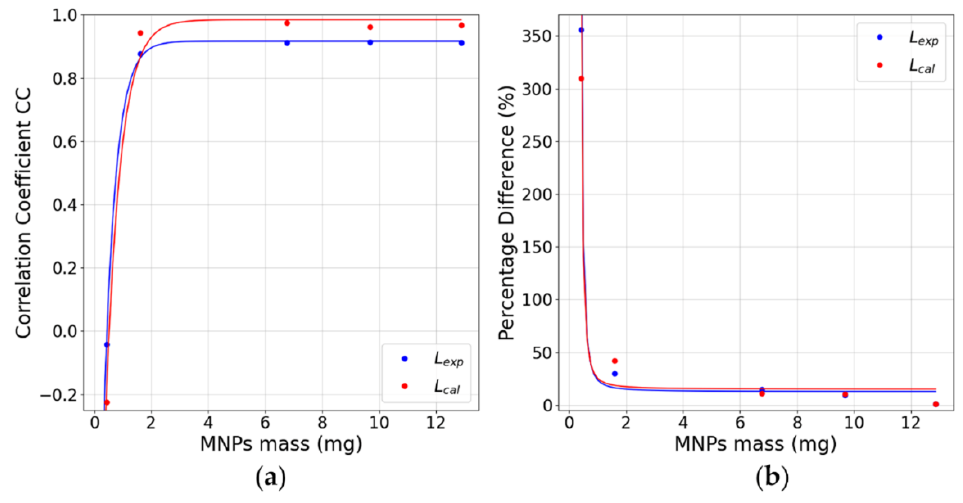
Figure 5. ( a ) CC values for reconstructing one cube in the FOV ’ s center. ( b ) 𝑋 𝑑𝑖𝑓𝑓 values for the reconstruction of one cube positioned in the FOV ’ s center. All graphs present the values for all MNP masses used. Fitted curves presented 𝑅 2 > 0.98. Table 1. CC and 𝑋 𝑑𝑖𝑓𝑓 estimated values for the reconstructions of one MNP loaded cube in the center of the FOV. Each cube contains a different MNP mass 𝑋 𝑛𝑜𝑚 .